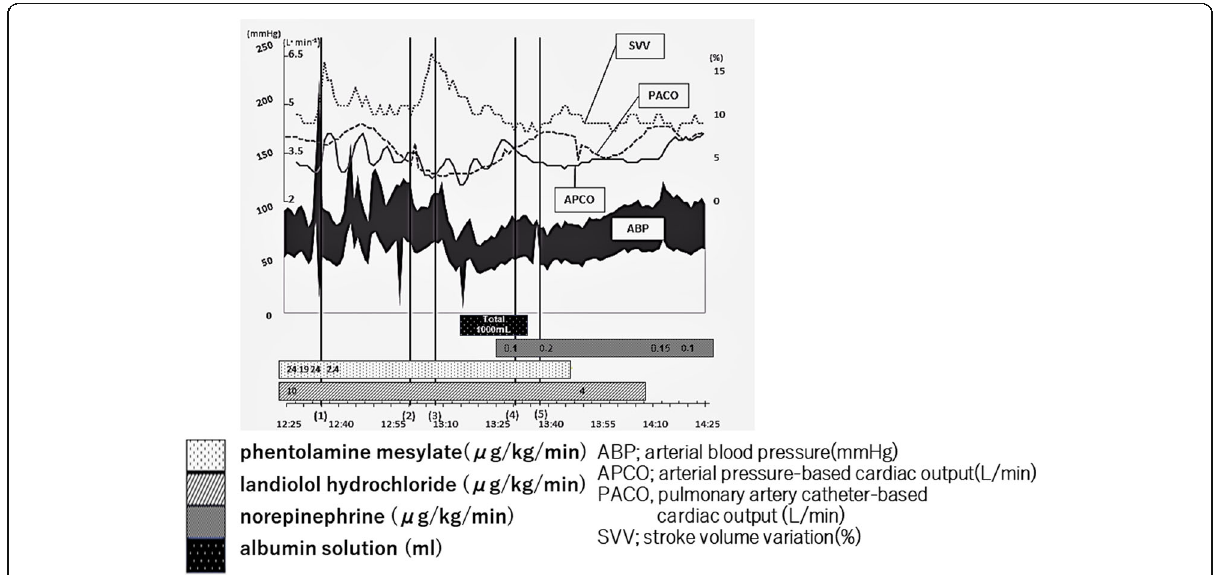
Fig. 3 Chart showing the change in intraoperative hemodynamics with the values of circulatory monitors. Compared with pulmonary arterial catheter-based cardiac output (PACO), arterial waveform-based cardiac output (APCO) fluctuated more wildly in a different way from arterial blood pressure (ABP), especially while the right adrenal gland vessels were being resected, though the continuous infusion dose of propofol and remifentanil remained unchanged. (1) 12:35 — there was a sudden surge in ABP immediately after the surgeons began operating the right adrenal gland, and a subsequent bolus injection of phentolamine mesylate decreased ABP. (2) 13:00 — devascularization of the tumor was completed. (3) 13:08 — stroke volume variation (SVV) increased from 10 to 17 after the devascularization. (4) 13:30 — a rapid infusion of albumin stabilized circulatory hemodynamics. (5) 13:38 — resection of the right adrenal gland tumor was